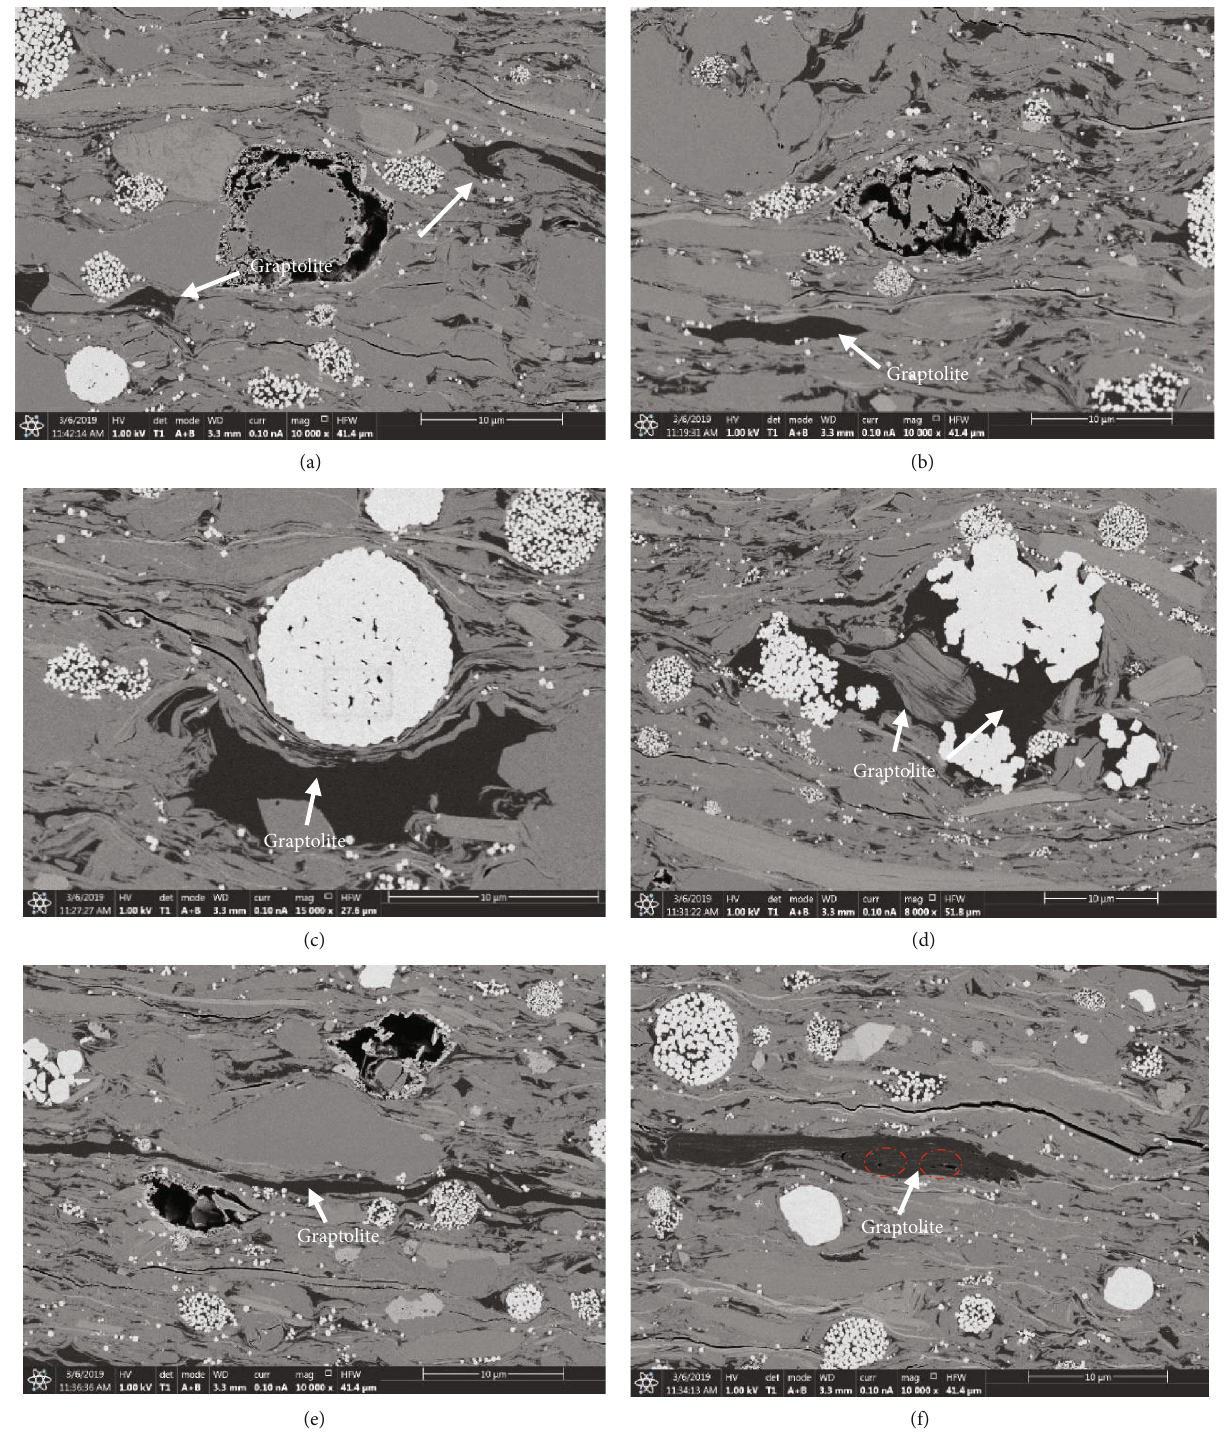
Figure 12: SEM images showing the typical habit and internal pore structure of organic matter in sample TRA-10. (a – f) Abundant graptolites and pyrite framboids distributed within the shale matrix. (a – c, e) Dispersed graptolite pieces without pores even enlarging current magni fi cation. (f) A few pores of irregular and narrow shape inside graptolite grains, and the existence of such pores is not common in the studied